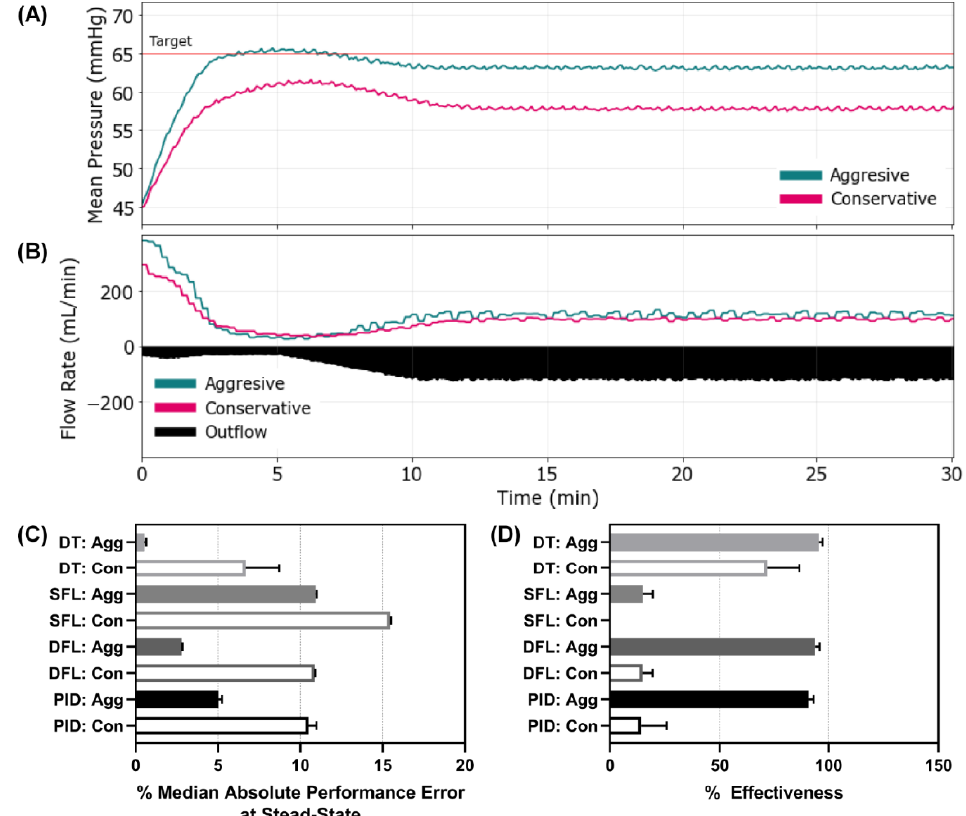
Figure 6. Controller performance for Scenario 4. Representative ( A ) MAP and ( B ) inflow/outflow vs. time for a single run of the aggressive and conservative dual-input fuzzy logic controller run through Scenario 4. Outflow rates are only shown for one controller run. In Scenario 4, MAP begins at 45 mmHg with an active hemorrhage that initially clots until the 5 min timepoint where clotting mechanisms were halted, and hemorrhage rates increased. Performance results for each controller type (DT = decision table; SFL = single-input fuzzy logic; DFL = dual-input fuzzy logic; PID = proportional – integral – derivative controller) and configuration (Agg = aggressive; Con = conservative) for the ( C ) median absolute performance error (MDAPE) at steady state (lower is better) and ( D ) effectiveness (higher is better). Average results are shown for three subject variability runs for each. Error bars denote the standard deviation.